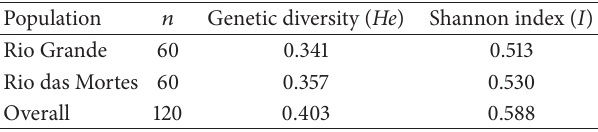
Figure 2: Resampling analysis (bootstrap) and the correlation ( 𝑟 ) with number of fragments from the Rio das Mortes population. SQd is the squared sum of the deviations in relation to the new samples; 𝐸 is the stress value. Table 2: Genetic diversity and Shannon index for two Calophyllum brasiliense populations